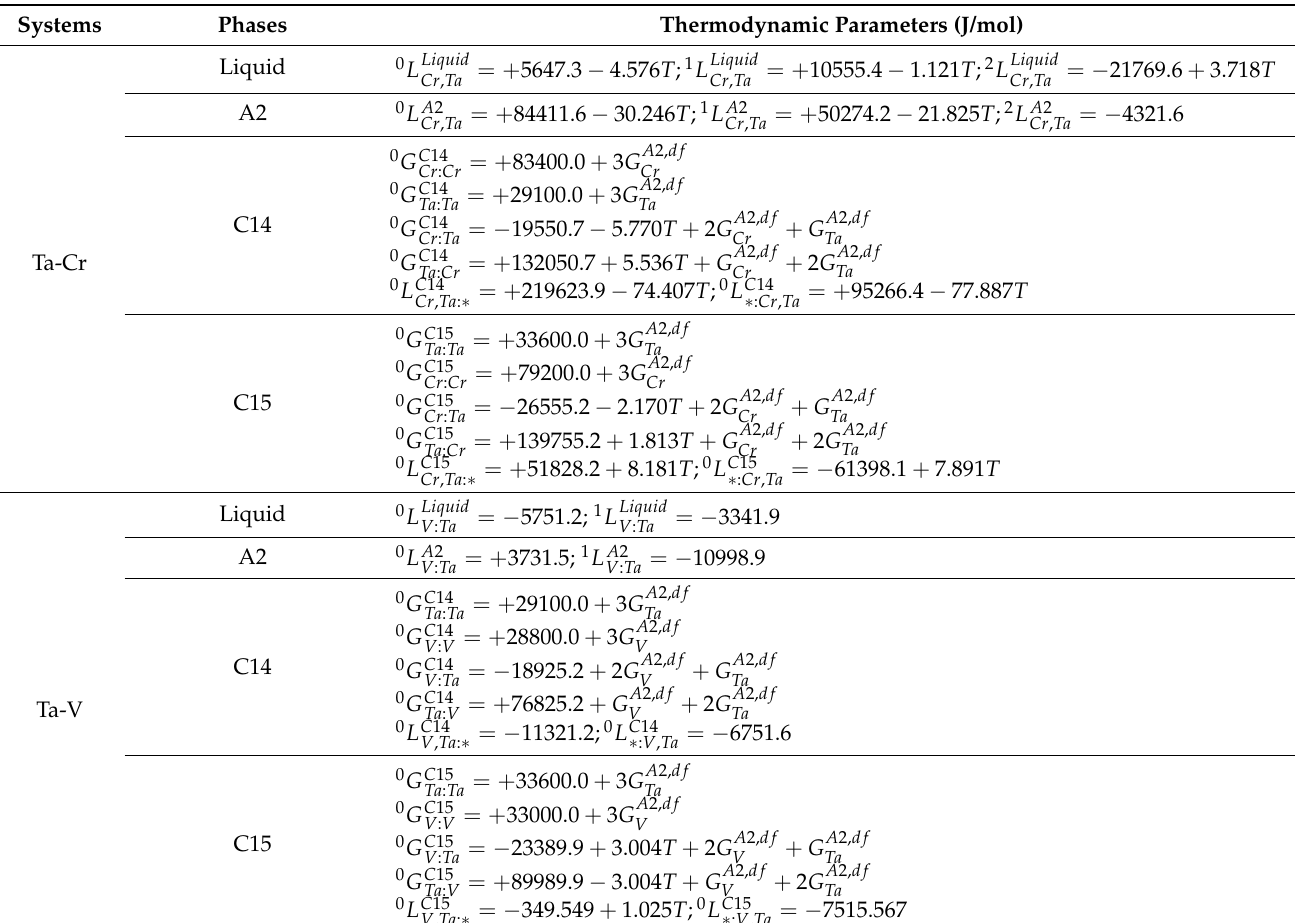
Table 2. Summary of the thermodynamic parameters of Ta-Cr and Ta-V binary systems. Systems Phases Thermodynamic Parameters